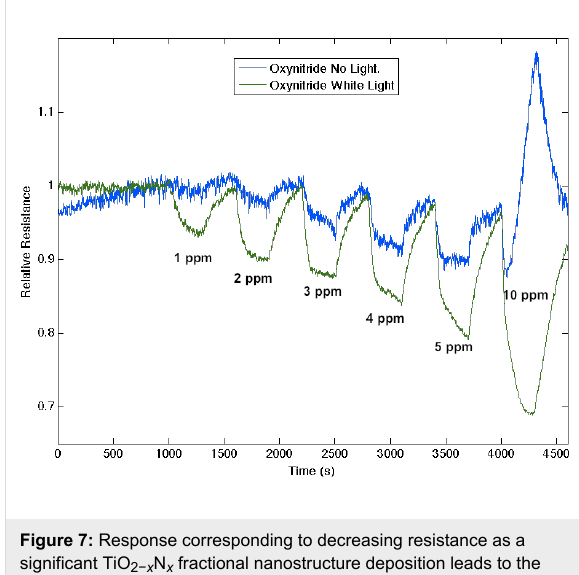
Figure 6: Response corresponding to increased resistance as NO 2 extracts electrons from a TiO 2 treated n-type PS interface without light exposure (blue) and the same interface exposed to UV radiation (green). Note that the response reverses with light exposure indicating that a more acidic TiO 2 is now extracting electrons.